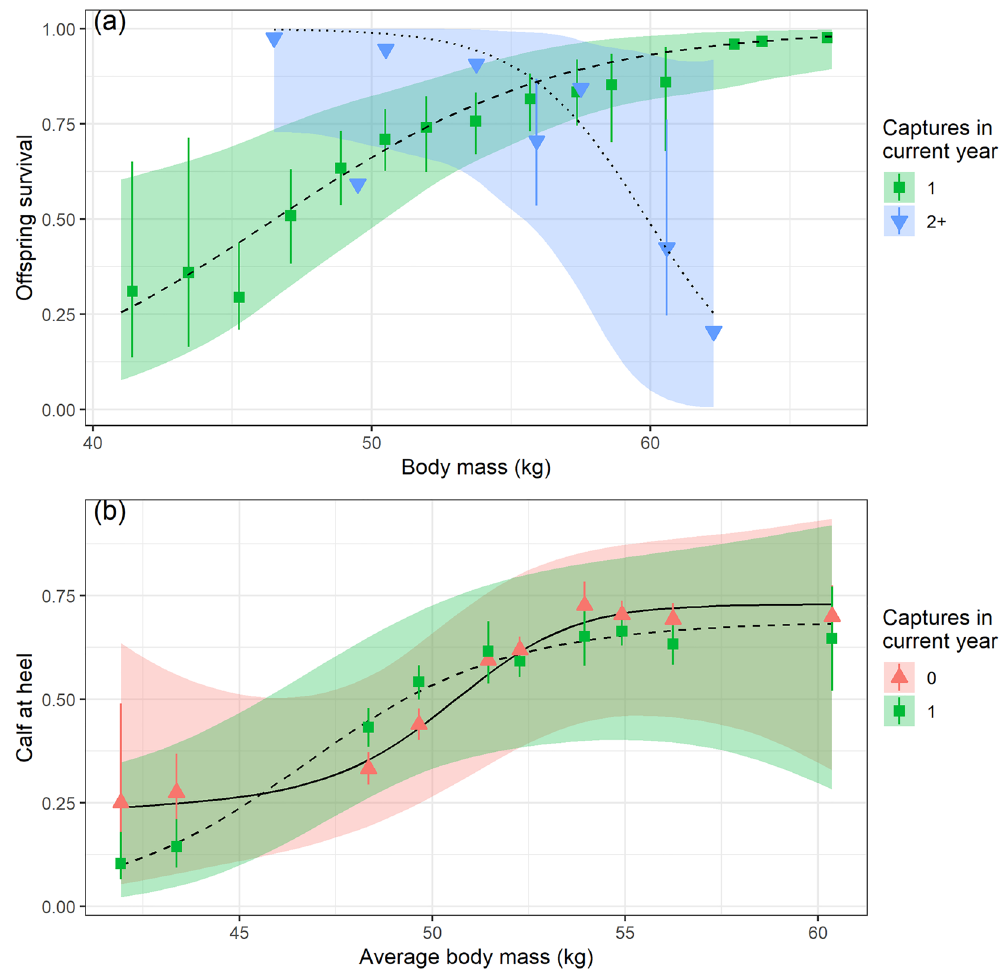
Figure 6. Reproductive success of female Svalbard reindeer as a function of body mass in winter (April). ( a ) Offspring survival to summer for females who were pregnant in winter and captured either once (green squares) or repeatedly (2–4 times; blue downward triangles) in winter. Each body mass relates to a specific individual. ( b ) Presence of calf at heel in females in summer as a function of the mean annual winter body mass, in females who had either not been captured (red, upward triangles, solid line), been captured once (green, squares, dashed line). Predictions are drawn from the model with lowest AICc (Tables S15 and S17). Shaded areas show 95% confidence intervals (CI) of the predictions. Points show average ± CI adjusted for year and ID, binned into equal-sized mass